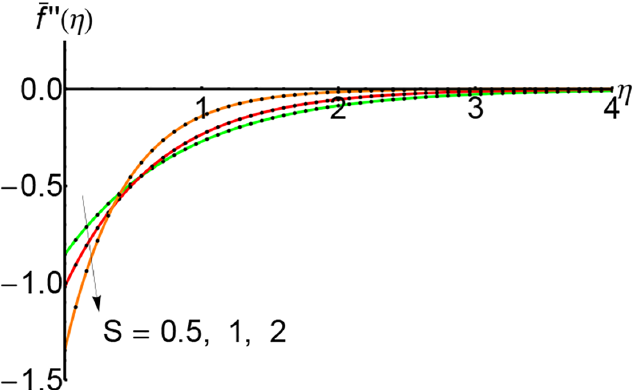
Fig 8. Variation of horizontal velocity (cid:2) f 0 ð Z Þ with η for different values of suction parameter S and for λ = 0.5: —— numerical solution ......... . OHPM solution.